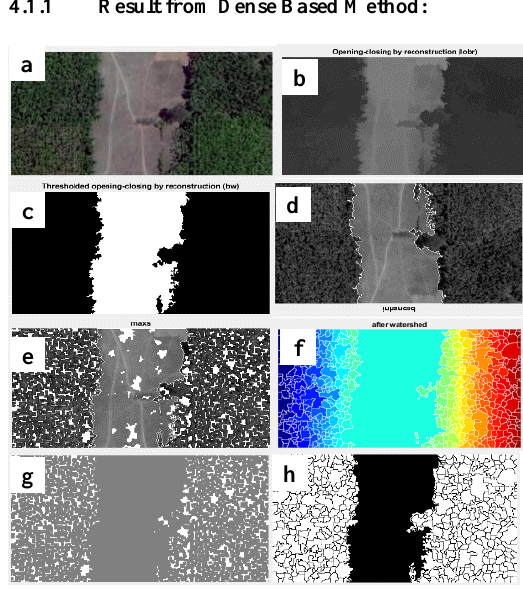
Figure 6 (a) Original image, (b) Opening and Closing by Reconstruction, (c) Thresholded image, (d) Overlay Image, (e) Regional Maxima, (f) Watershed Segmentation, (g) Reduced Regional Max, (h) Watershed Segmentation